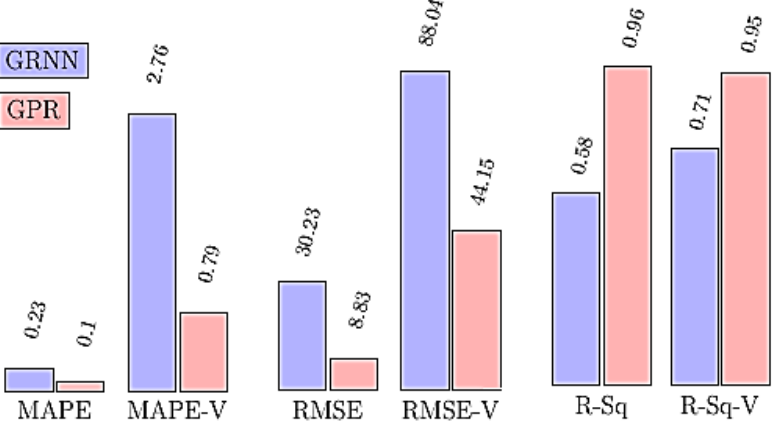
Figure 9. Comparison histogram of model characteristics.